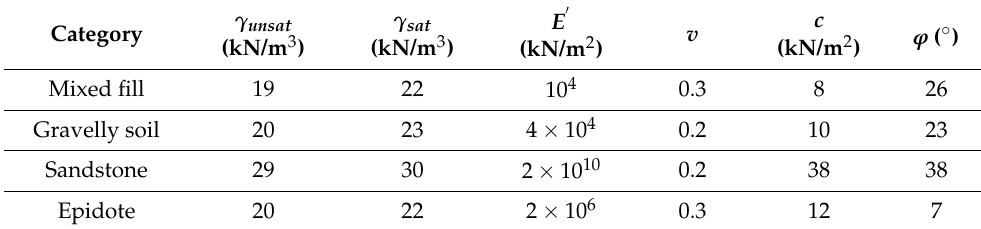
Table 1. Physical and mechanical parameters of the rock formation.